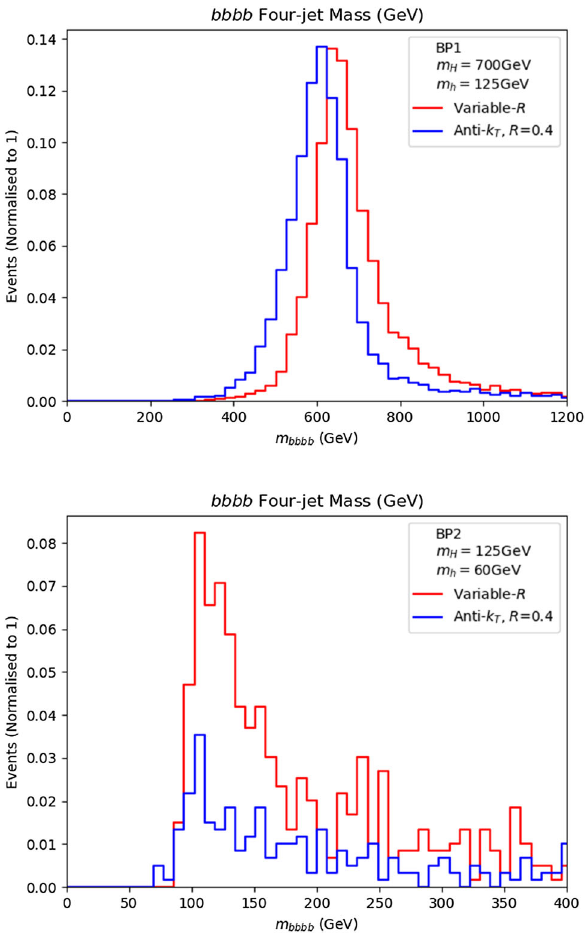
Fig. 10 The four b -jet invariant mass m H distributions from four jets obtained from jet clustering for BP1 (upper panel) and BP2 (lower panel)